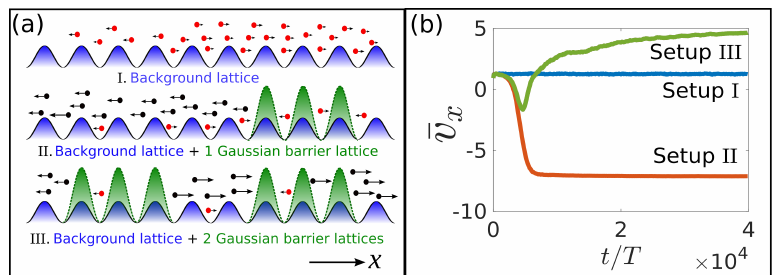
Figure 1. ( a ) Schematic representation of a slice of our 2D setup along the x -direction and viewed along the y -direction. The filled dots denote particles and the colors red and black denote diffusive and ballistic motion respectively. The arrows denote the direction of motion of the particles at asymptotic timescales ( t = t f ) with the length of the arrow being proportional to the magnitude of the x component of their velocities, i.e., v x . In the presence of only the driven background lattice V B depicted in blue (setup I, upper panel), most particles exhibit diffusive/chaotic transport towards right, hence the average transport is along the positive x -direction. On superimposing a finite lattice of 2D Gaussian barriers V G 1 (in green), most particles undergo a conversion from diffusive to ballistic motion leading to a reversal of their average transport direction (setup II, middle panel). Their velocities can be reversed once again due to the superposition of a second identical lattice of Gaussian barriers V G 2 , thus leading to a second current reversal. The external driving force is along the x -direction. ( b ) Mean transport velocity of the ensemble along the x -direction as a function of time for the three different setups. U G ( R mn ) = 0 for all ( m , n ) in setup I. For the setup II, U G ( R mn ) = 5 for 5 × 10 3 < m < 10 4 and vanishes elsewhere whereas for setup III, U G ( R mn ) = 5 for 5 × 10 3 < | m | < 10 4 and zero elsewhere. Remaining parameters: U B = 1.0, β = 5, d =